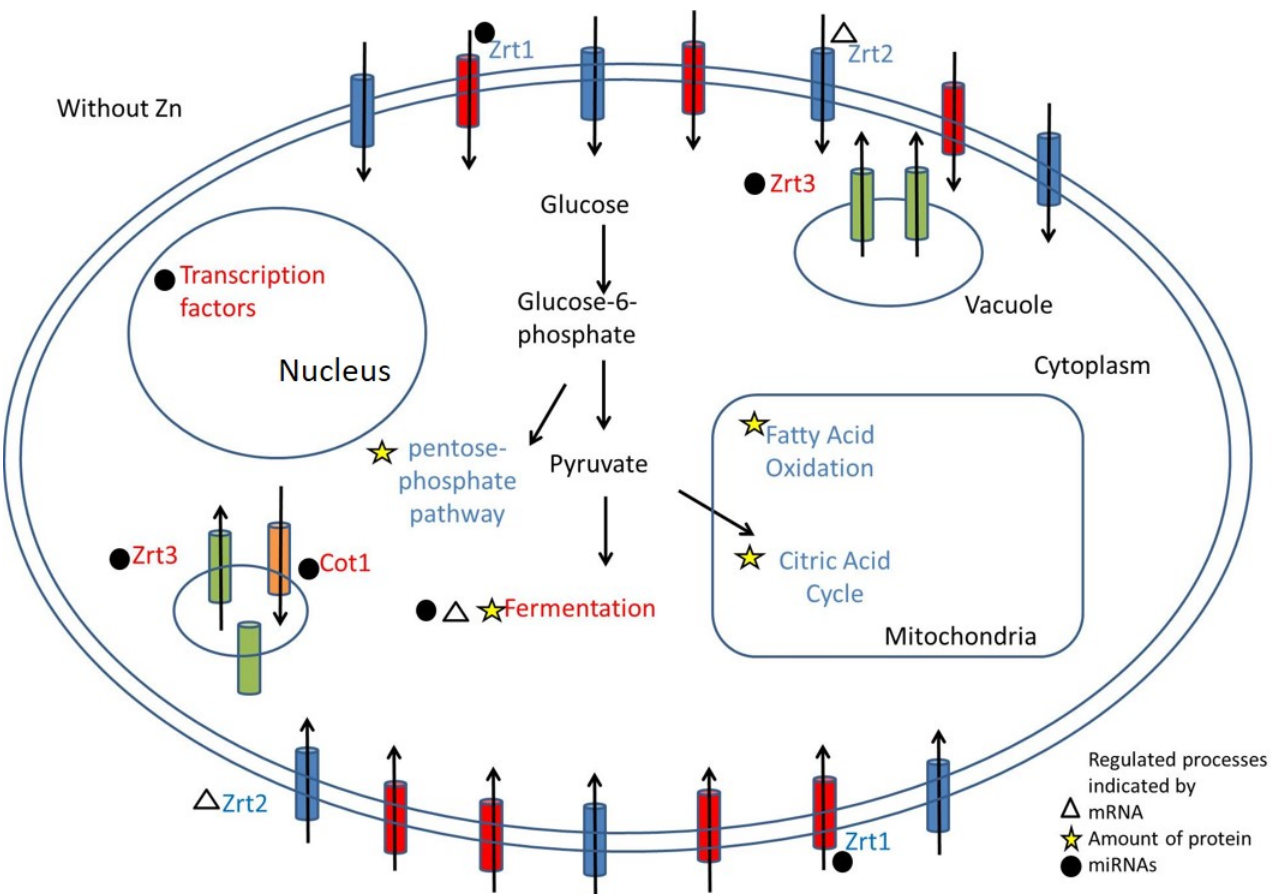
Figure 2. Hypothetical model of the response to zinc deprivation of P. brasiliensis . Letters in blue show processes that were induced and letters in red show processes that were suppressed. The image shows the altered metabolic processes during zinc deprivation in addition to the approach used in the study that indicated this alteration. Triangles mark processes indicated by changes in mRNA. Stars show processes indicated by the proteome and spheres indicate changes indicated by miRNAS.